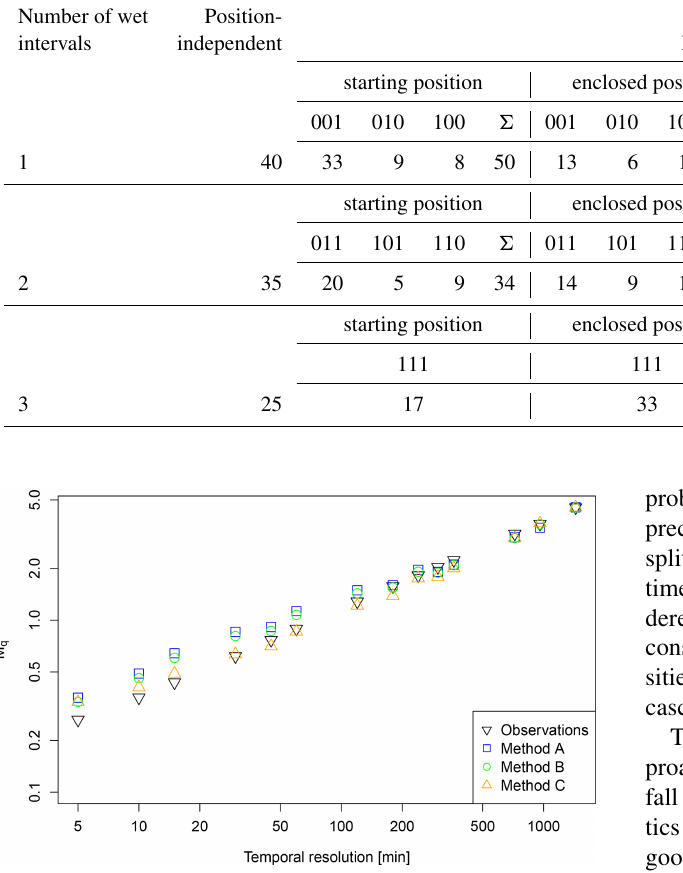
Figure 6. Scaling behaviour of observed and disaggregated time se- ries for station Cuxhaven for q = 1. Each value represents the mean of 30